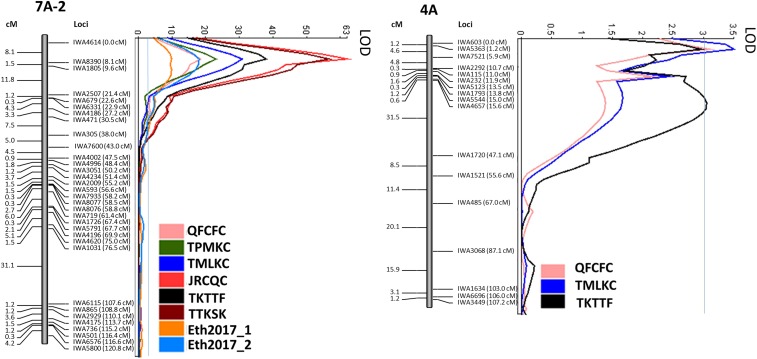
Mapping of stem rust resistance QTL (QSr.ace-4A and QSr.ace-7A) in the population Rusty × PI 192051-1 at seedling stage to races QFCFC, TPMKC, TMLKC, JRCQC, TKTTF, and TTKSK and at adult plant stage in stem rust nursery in Ethiopia in 2017. All QTL were identified using composite interval mapping. The QTL analysis LOD threshold is shown with the blue horizontal line. Co-segregating markers were excluded from these maps. SNPs and their cosegregating markers are presented in Figure S2.